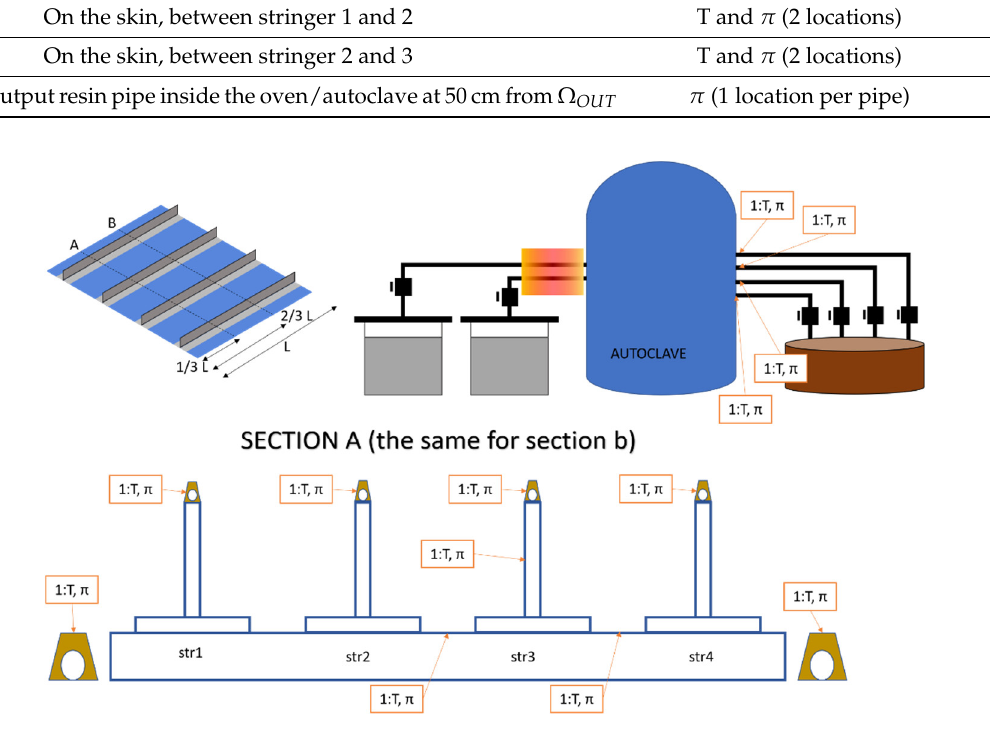
Figure 2. Comprehensive scheme of the sensorized panel and the infusion plant.